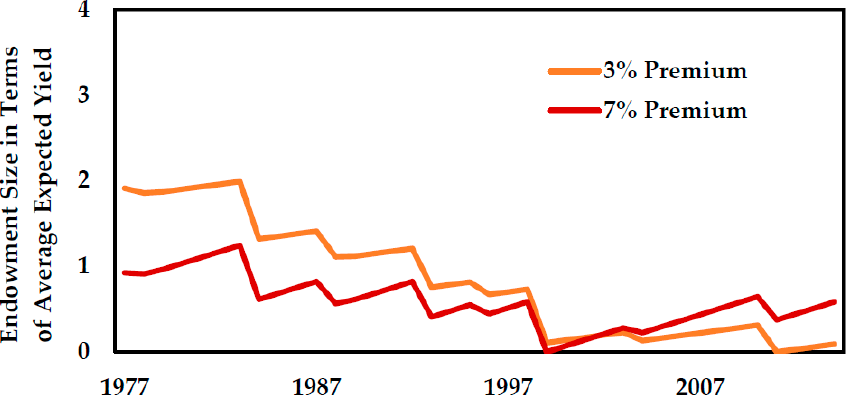
Figure 5. JFM product evaluated under 7% and 3% premium scenarios.